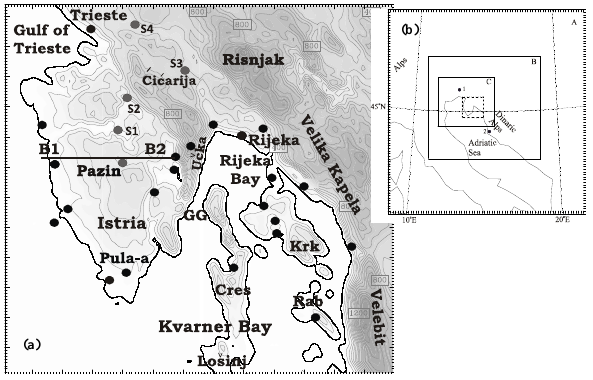
Fig. 1. (a) A close-up of the NE Adriatic (dotted rectangle in the up- per right panel) with topography depicted by contours every 100m (for geographical details see the text) between 0 and 1500m. Cir- cles represent the positions of measuring sites; hourly meteorolog- ical (Pazin, Pula-a and Rijeka) and climatological measurements. The thick solid black line denotes the base of vertical cross-section (B1B2) shown in later figures and Table 2. (b) The upper right panel indicates the coarse-grid (A), mid-frame (B) and fine-grid (C) WRF model domains, respectively. Numbered dot 1 denotes Udine (46.03 ◦ N, 13.18 ◦ E) radio sounding station and dot 2 correspond to the radio sounding station Zadar (44.10 ◦ N, 15.35 ◦